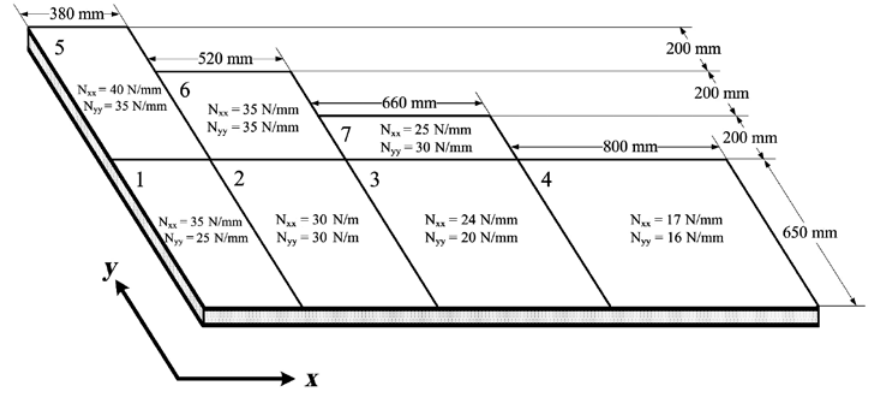
Figure 11: The seven-sandwich-panel structure.